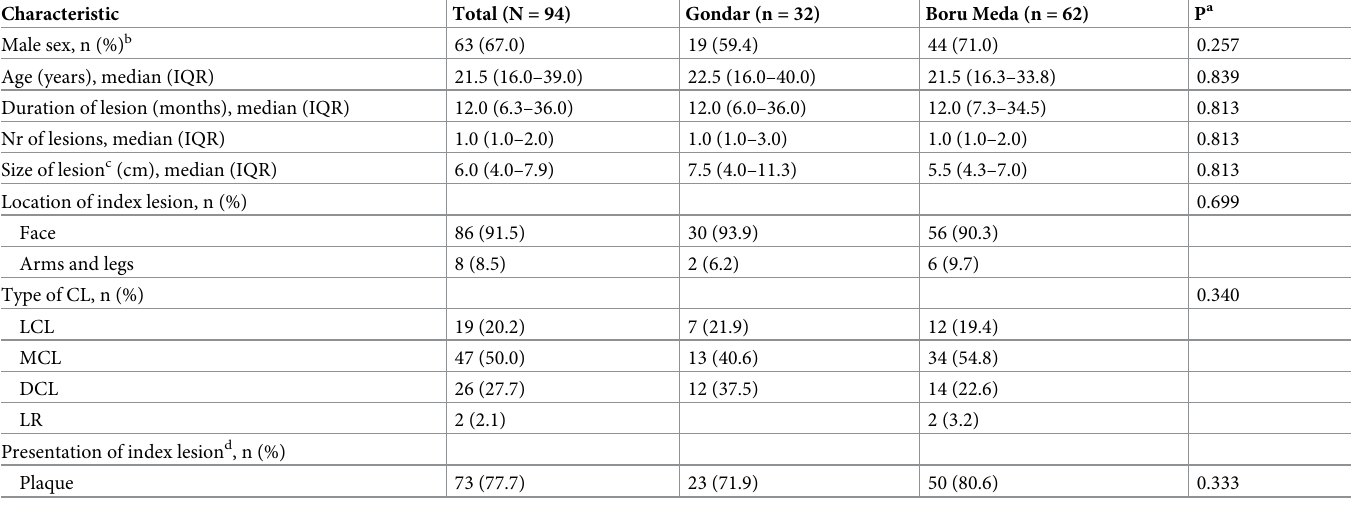
lesions were more often scaly and exfoliative. The proportion of patients with DCL was higher in Gondar (12/32, 37.5%) than in Boru Meda (14/62, 22.6%) (Table 2). For eight patients no skin slit sample was taken at day 0, of which two were positive previ- ously, and two at the follow-up visit. In 46/86 (53.5%) samples Leishmania was confirmed using microscopy. Four slides (2 microscopy positive) were not available for PCR; 79/86 (91.9%) PCRs were positive, 1 (1.2%) negative, and 6 (7.0%) invalid. For ten patients CL was never confirmed. All five patient samples from Boru Meda selected for species typing were confirmed to be L . aethiopica infections (see S1 Fig).